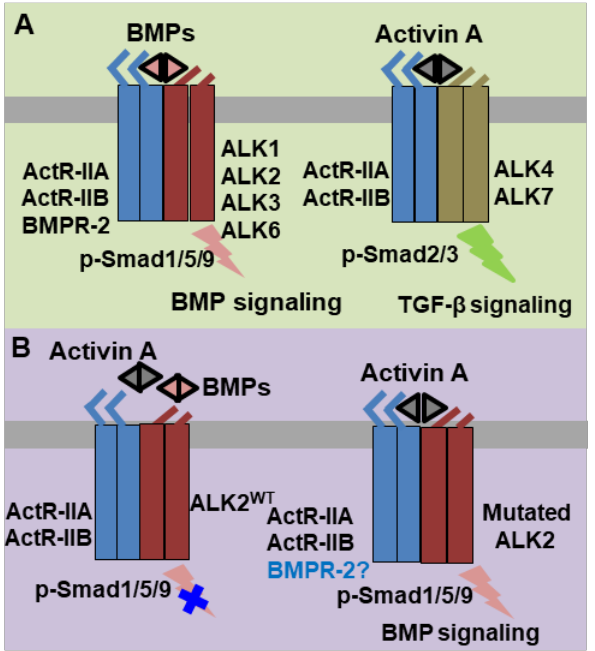
Figure 1. Scheme of physiologic bone morphogenetic protein (BMP) and activin A signaling pathways and abnormal activin A-induced BMP signaling in Fibrodysplasia Ossificans Progressiva (FOP). ( A ) BMPs and activin A normally assemble and bind to a heterotetramer complex consisting of a type II receptor homodimer (BMPR-II/ActR-IIA/ActR-IIB for BMPs and ActR-IIA/ActR-IIB for activin A) and a type I receptor homodimer (ALK1/2/3/6 for BMPs and ALK4/7 for activin A) to transduce signaling via Smad phosphorylation ( p -Smad1/5/9 for BMPs and p -Smad2/3 for activin A). ( B ) Under normal circumstances, activin A competitively counteracts BMPs that induce BMP signaling through ALK2. However, in FOP, activin A can sensitize the mutated ALK2 to phosphorylate Smad1/5/9 for abnormal BMP signaling transduction.